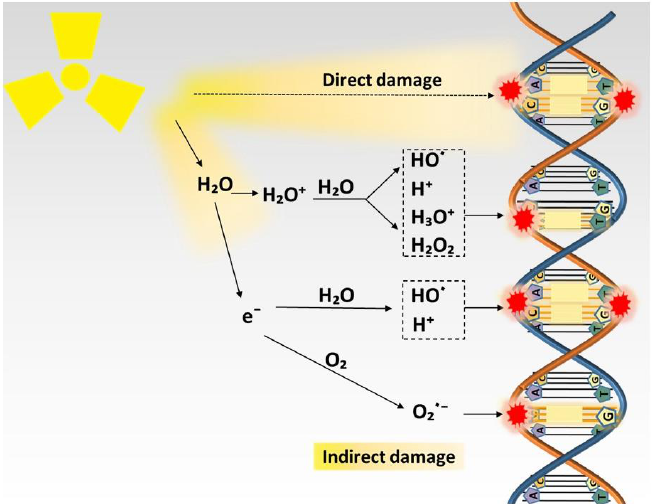
Figure 1. Direct and indirect actions of radiation. In direct reaction, radiation directly interacts with DNA resulting in DNA damage. In indirect reaction, radiation interacts with other molecules in the cells, particularly water, to produce free radicals such as hydrogen atoms (H + ), hydroxyl radicals (HO), and superoxide radical anion (O 2 − ), which in turn induce the damage to the DNA.